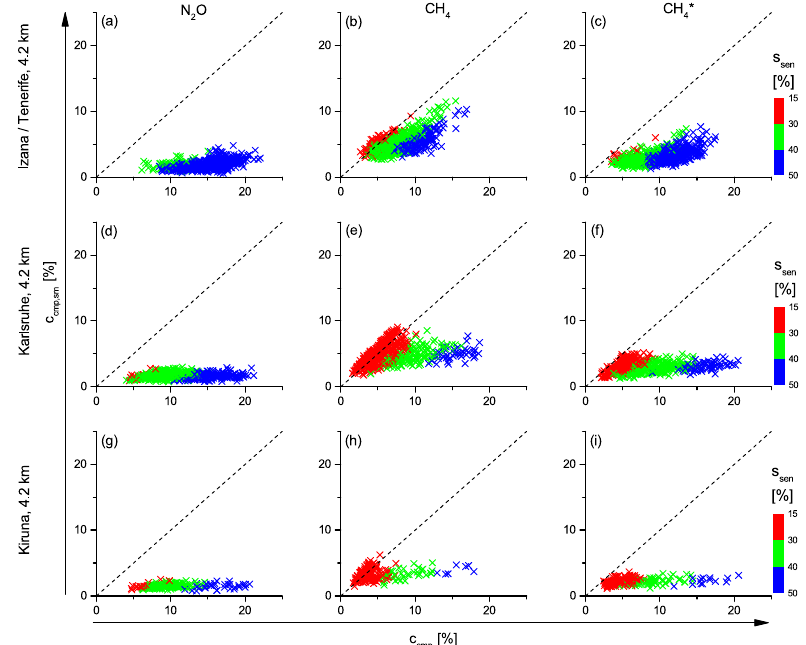
Figure D1. Comparability of MUSICA IASI and NDACC FTIR remote sensing data at 4.2km. Shown are correlations between the c cmp and c cmp , sm values calculated according to Eqs. (D2) and (D3), respectively: (a–c) for the surroundings of Tenerife Island; (d–f) for the surroundings of Karlsruhe; (g–i) for the surroundings of Kiruna; (a) , (d) and (g) for N 2 O; (b) , (e) and (h) for CH 4 ; and (c) , (f) and (i) for CH ∗ . The colour code shows the MUSICA IASI c sen values according to Sect. 3.2. 4